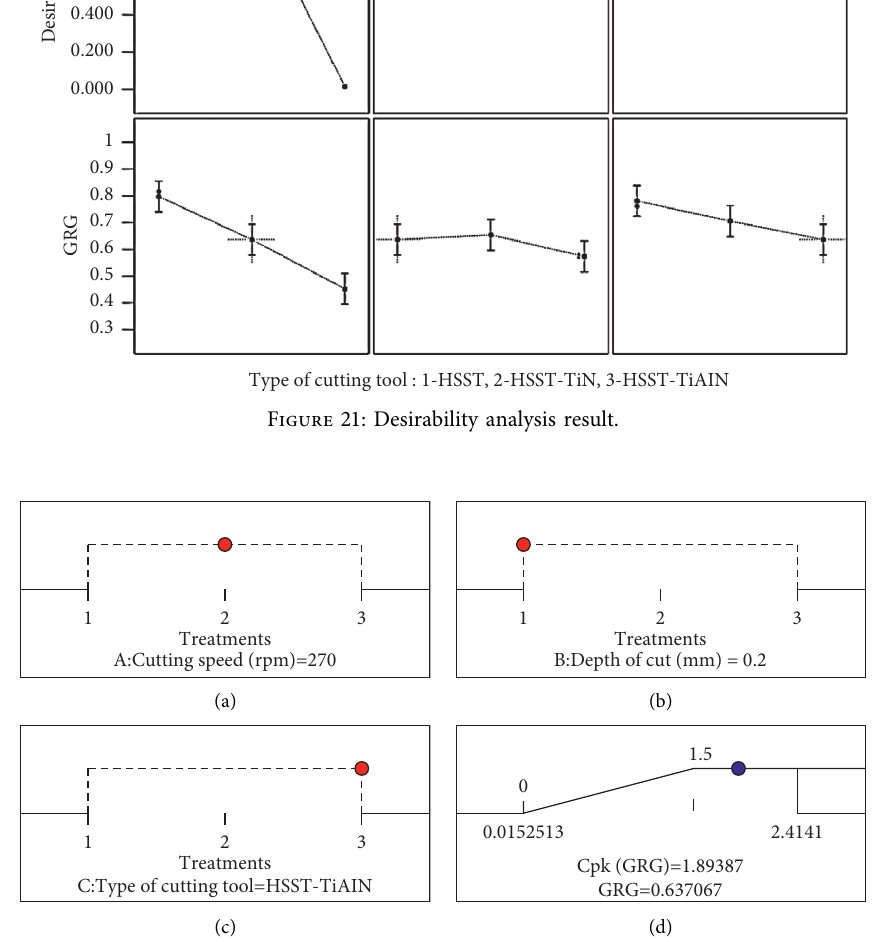
Figure 22: Ramp function graph for desirability